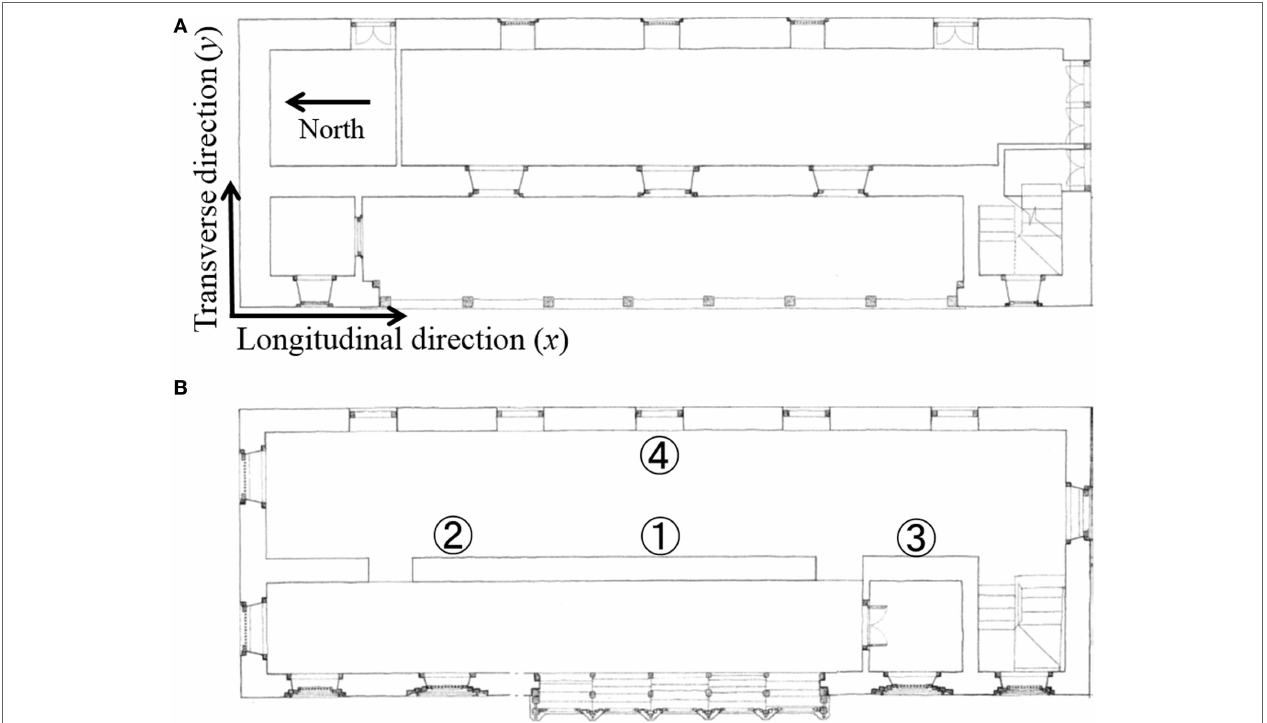
FIGURE 4 | Plan view of the target building with numbered measurement locations. (A) Plan view of the ground floor. (B) Plan view of the upper floor.